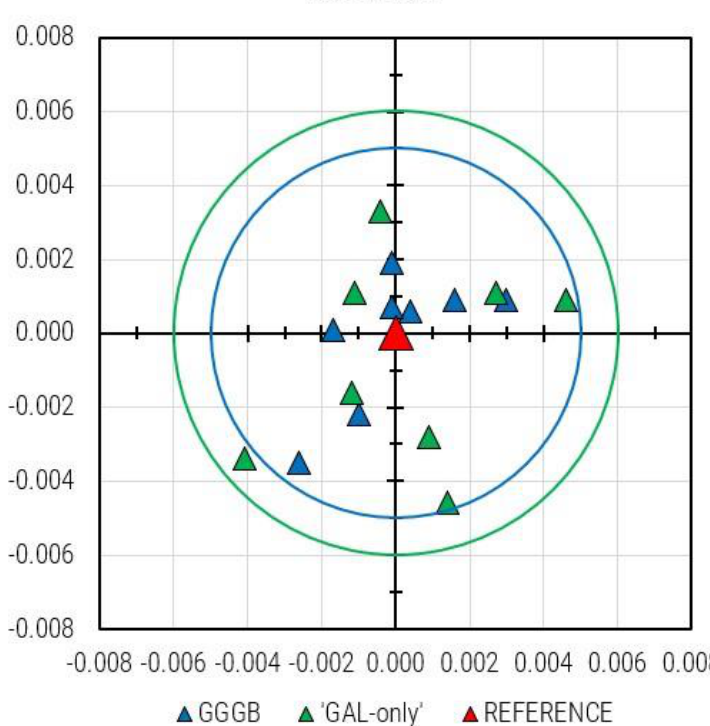
Figure 8. All individual static GGGB and ‘GAL-only’ sessions results plotted together: green circle (6 mm) and cyan circle (5 cm) show the maximum departure of ‘GAL-only’ and GGGB from the REFERENCE solution, respectively.